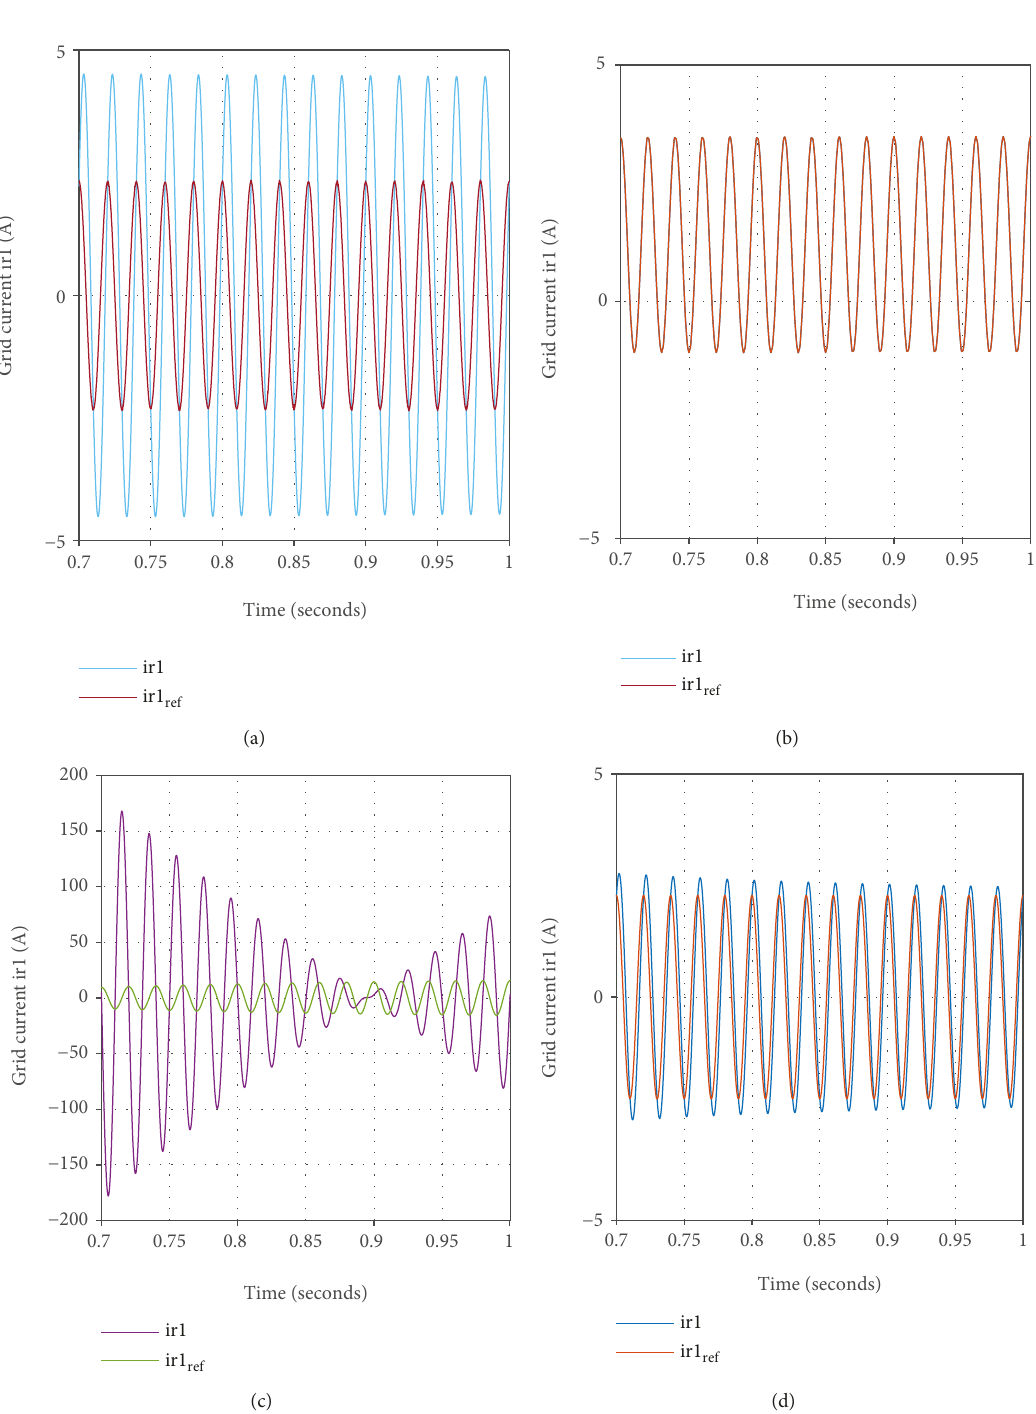
Figure 21: The e ff ect of line resistance sudden decrease on the grid currents by using (a) PSO-PID; (b) TLBO-FOPID; (c) ACO-PID; (d) Figure 17 validates the DC link voltage controller which is able to force the measured DC link voltage to track its reference when the system experiences a 50% voltage dip without limitation of the grid current amplitude at t = 0 8 s, 0 9 s